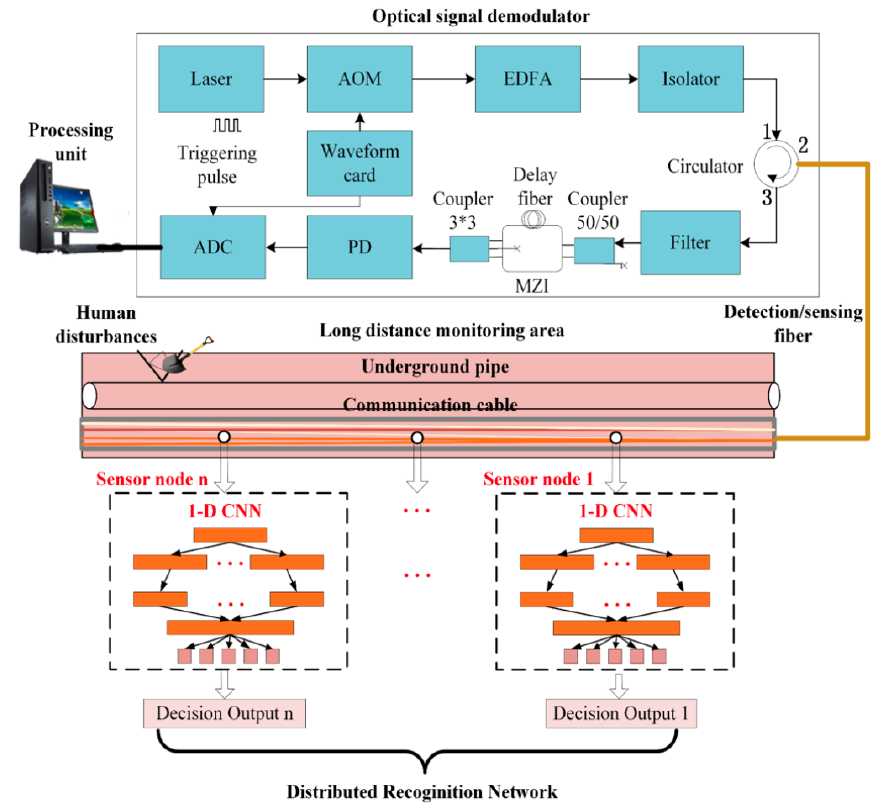
Figure 8. System structure and its distributed recognition scheme for safety monitoring of long distance buried oil pipelines with hybrid fiberoptic acoustic sensor (DAS) from [132], Copyright 2019, IEEE Xplore.